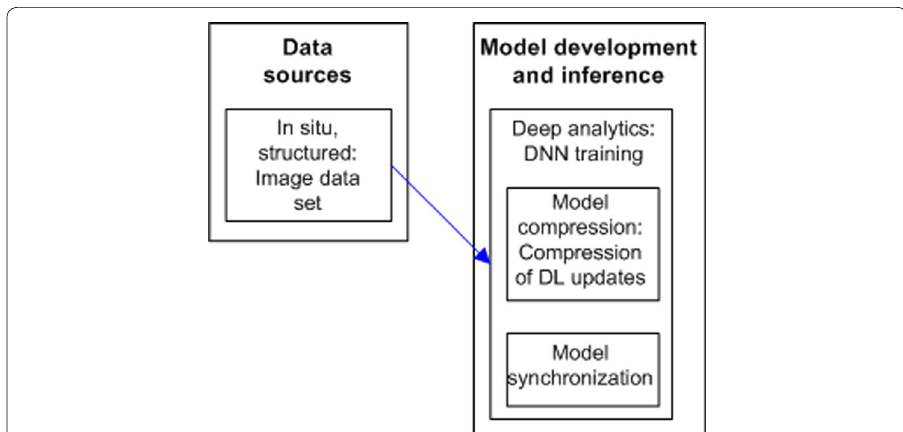
Fig. 15 The mapping of Adacomp [35] to the big data RA